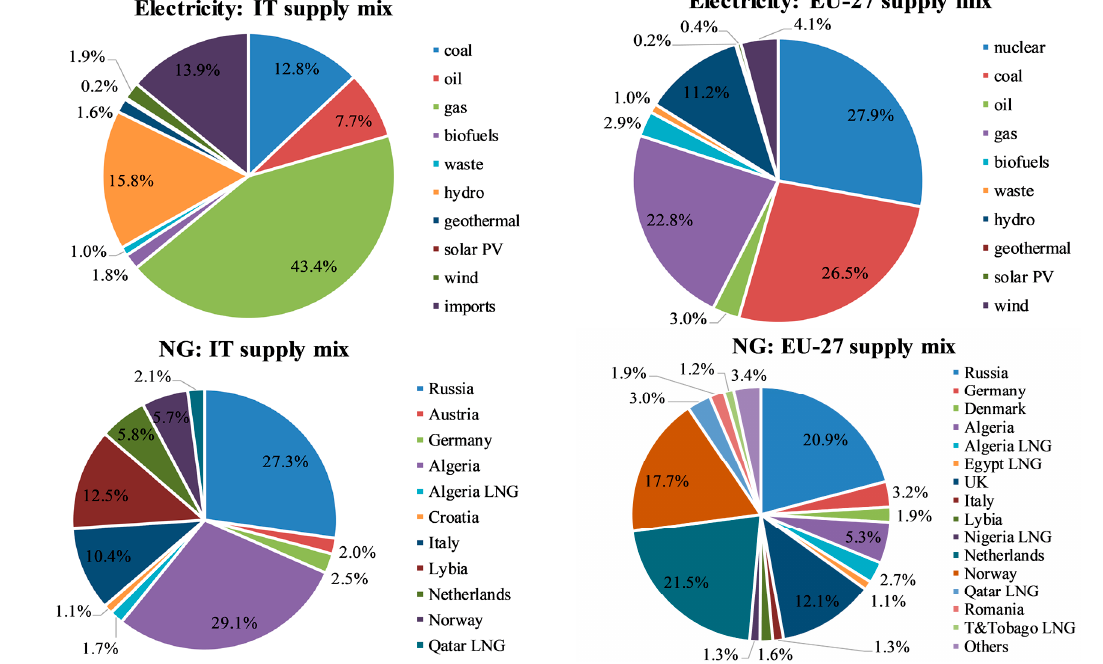
Figure 10. Energetic mixes used for the sensitivity analysis.